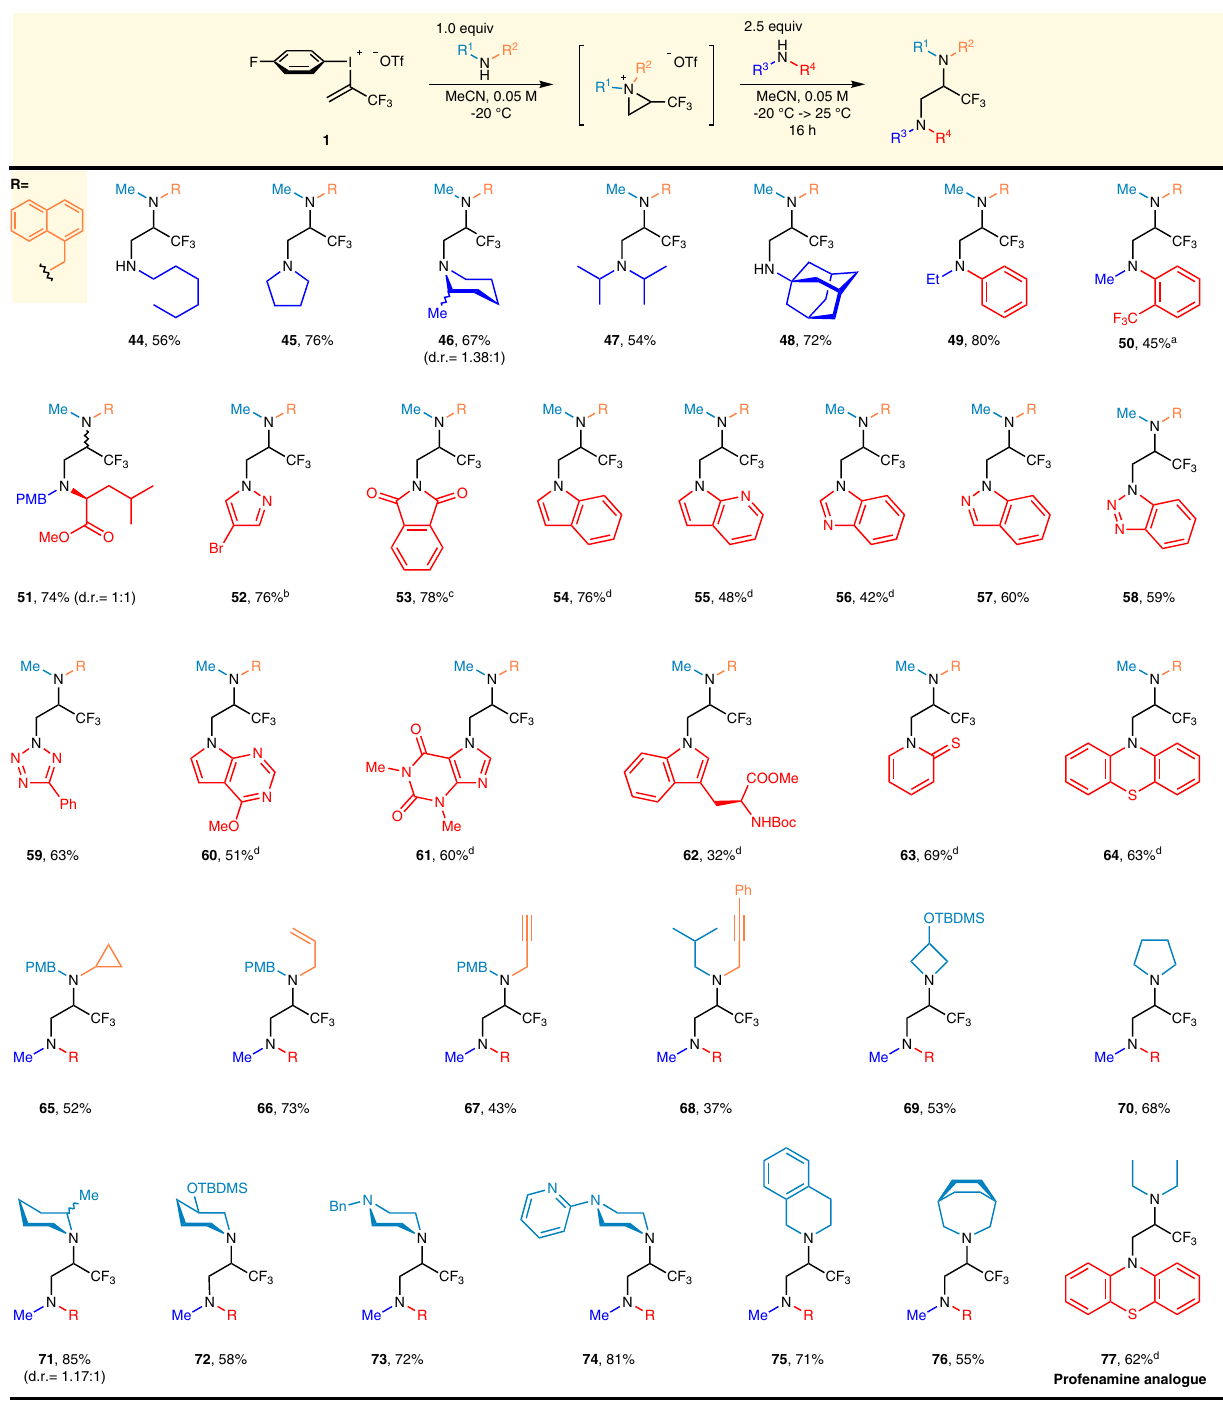
Fig. 4 Scope of heterodiamination. 1st stage: 1 (0.2 – 0.3mmol) added at 0.3mmolh − 1 rate, R 1 R 2 NH (1.0 equiv.), MeCN, c = 0.05M, − 20°C, 0.16hmmol − 1 ; 2nd stage: R 3 R 4 NH or Nu (2.5 equiv.), − 20 → 25°C, 16h. a Additional base: 2.5 equiv. 2,6-di- tert -butylpyridine. b Additional base: 2.5 equiv. NaH. c Potassium phthalimide was used. d 2nd stage: 2.6 equiv. R 3 R 4 NH, 2.5 equiv. LiHMDS, 2.5 equiv. HMPA, THF, − 78 → 25°C,